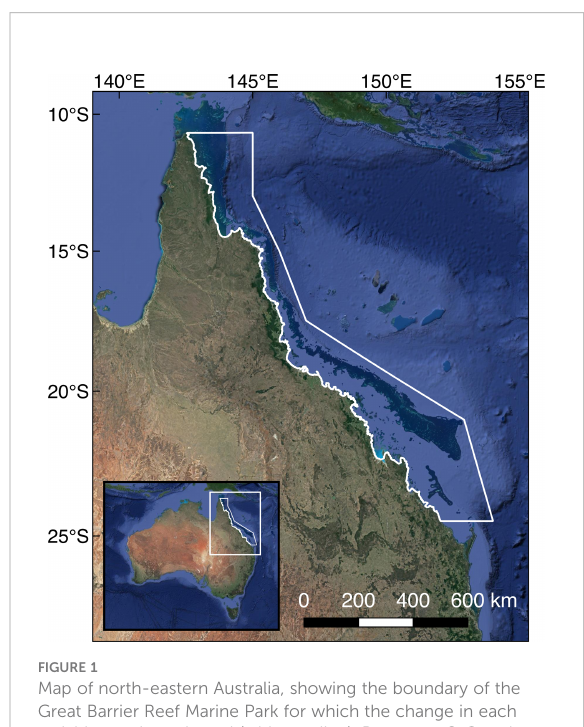
FIGURE 1 Map of north-eastern Australia, showing the boundary of the Great Barrier Reef Marine Park for which the change in each variable was investigated (white outline). Base map © Google Earth